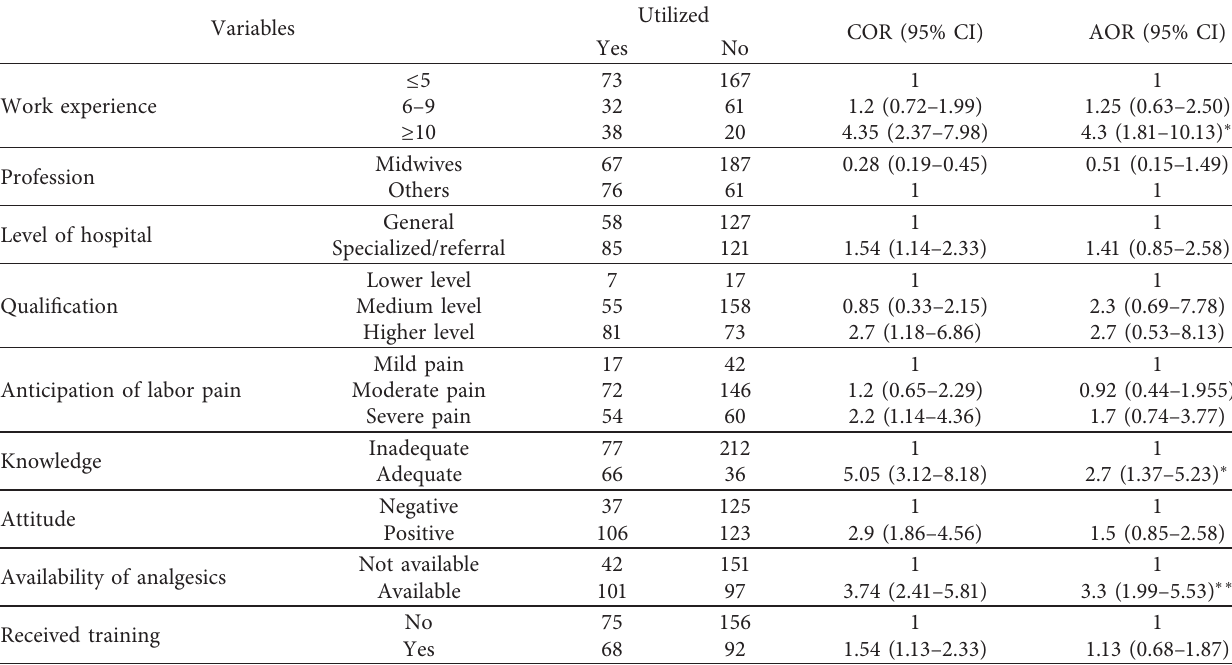
Table 5: Factors associated with utilization of obstetric analgesia among obstetric care providers in public hospitals of Addis Ababa, Ethiopia,